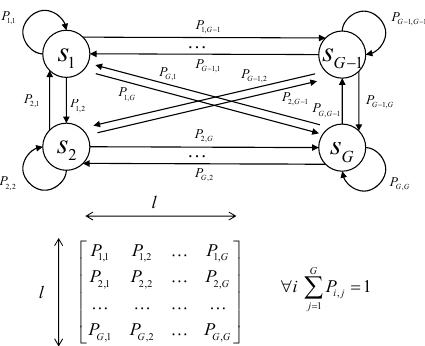
Figure 2. The schematic diagram of the FSMC, which contains G